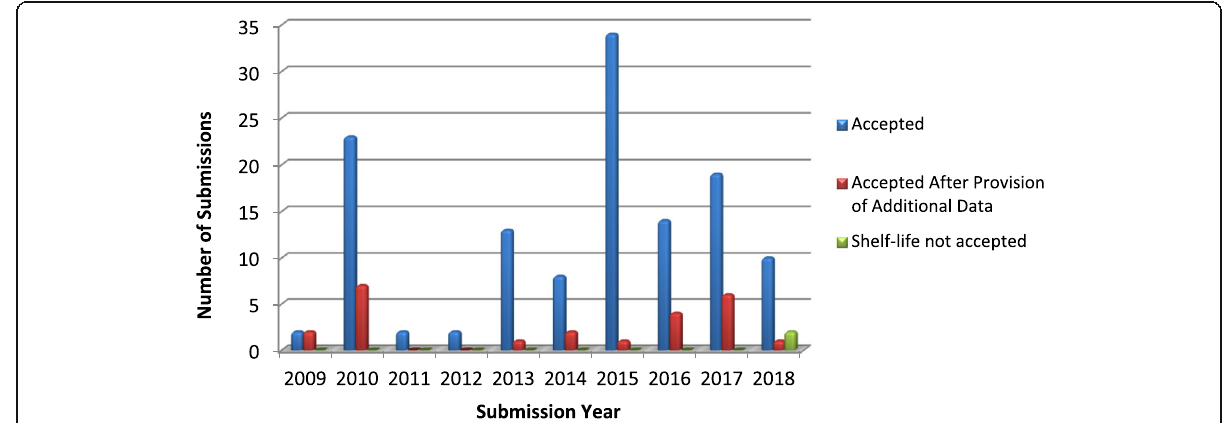
Fig. 2 Regulatory Experience Using RBPS to Set an Initial Shelf-life